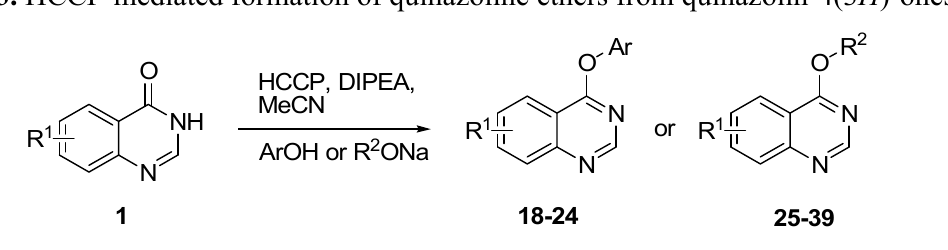
Table 3. HCCP-mediated formation of quinazoline ethers from quinazolin-4(3 H )-ones a